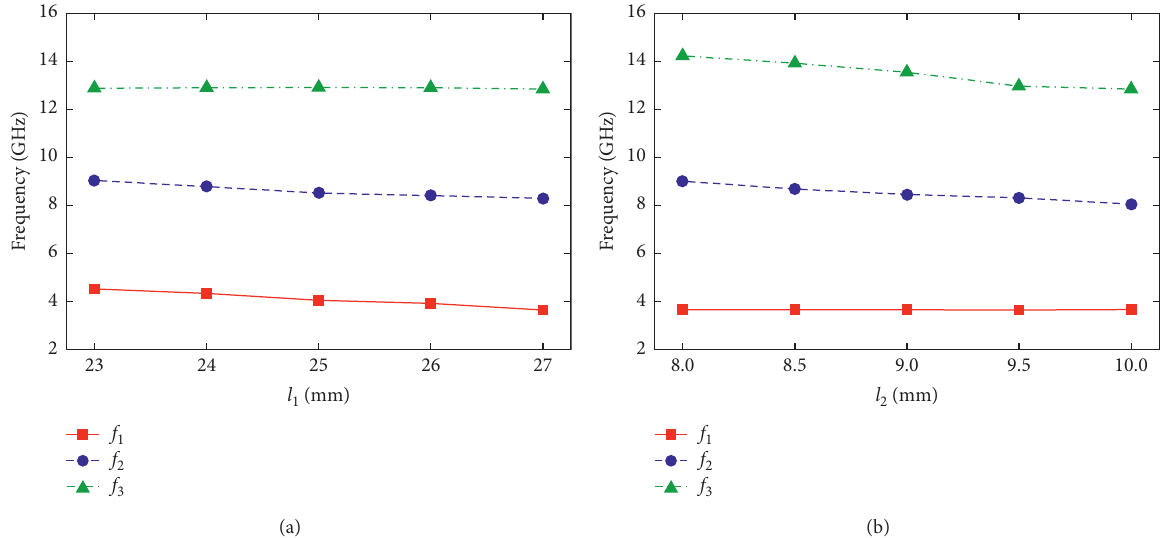
Figure 7: Variations of the reflection zero frequencies in the absorption band with respect to (a) the length l of the shorter strip. length l 2